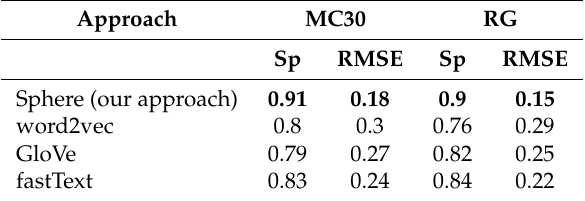
Table 3. Results of human-judged